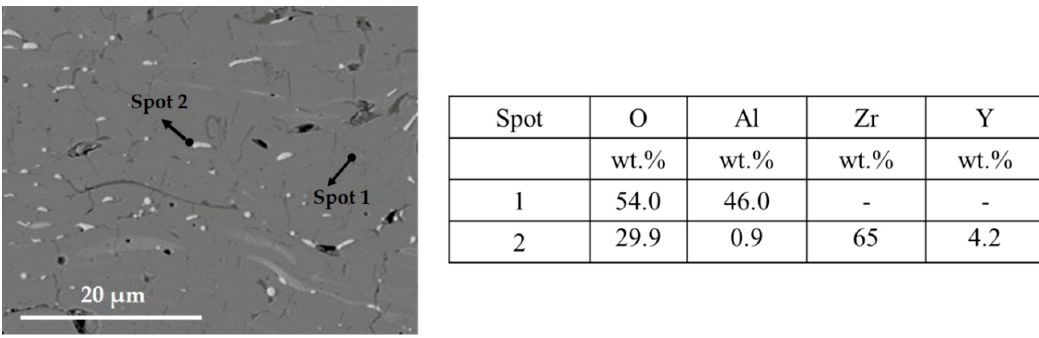
Figure 5. Energy dispersive spectroscopy (EDS) analysis on the cross-sectional SEM image of hybrid ApYs coating and its elemental composition taken at two different spots confirms the bright region to be Zr. Table 2. Percentage porosity values of the coatings.